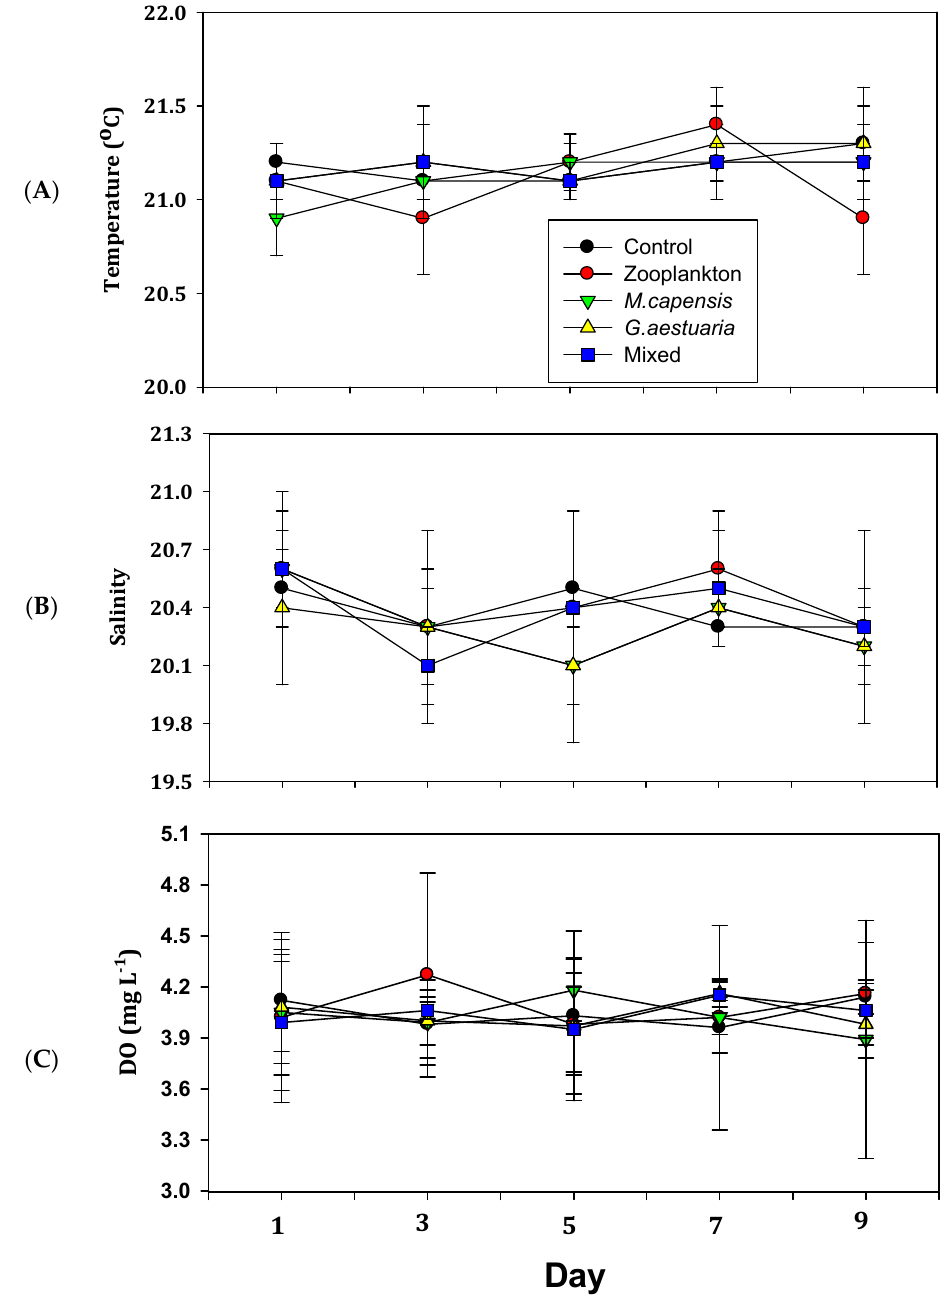
Figure 2. Mean ( ± standard deviation) temperature ( A ), salinity ( B ) and dissolved oxygen concentration ( C ) in different treatments during the 9-day mesocosm study conducted in the middle reach of the temporarily open/closed Kasouga Estuary on the south-east coast of South Africa (n = 3 for each treatment). Note the different scales on the y-axes.